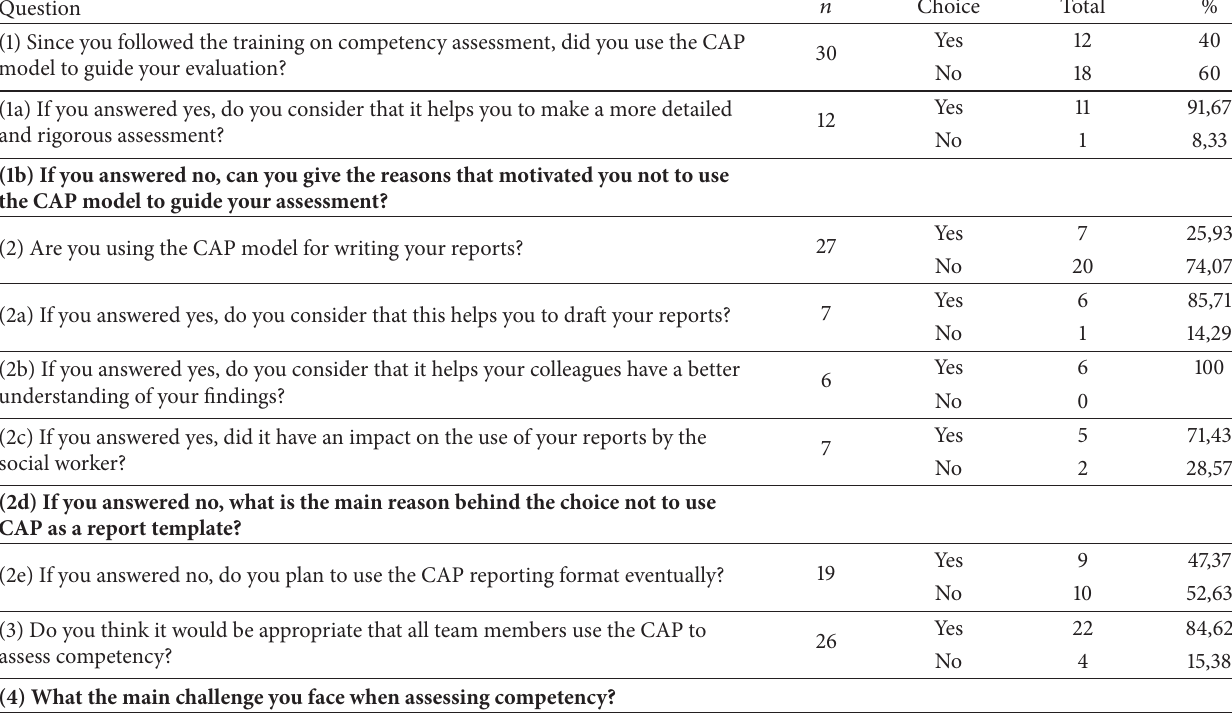
Table 2: Questions included in the survey and quantitative